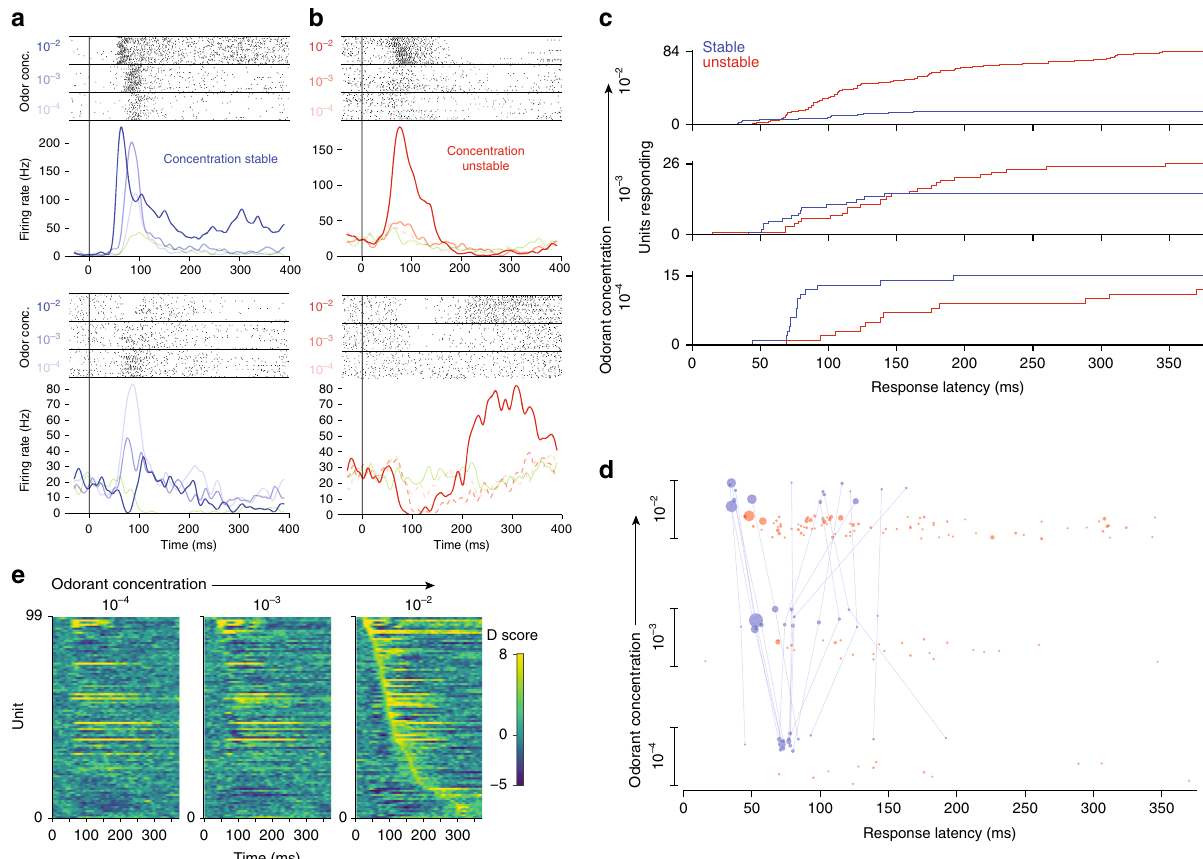
Fig. 4 Concentration invariant MT cell response latencies correspond with behavior. a Example raster and PSTH of two MT cells, which were responsive to odorant across 3 orders of magnitude concentration. t = 0 corresponds to inhalation onset. b Same plots for MT cells which respond to only a subset of concentrations. Dashed PSTH lines represent responses that did not cross the threshold for signi fi cance (see methods). c Cumulative distributions of MT cell response latencies. d Response latencies of MT cell-odor pairs across concentrations for concentration-stable and unstable units. Units ’ responses across concentrations are connected. Area of each point in the plot is proportional to the Cohen ’ s D-score of the response over non-odor response (see “ methods ” section). Point positions are randomly jittered on the concentration axis for visibility. e Odor responses sorted by units ’ response latencies at the highest concentration of odorant. Responses are represented as D-scores, where positive and negative scores are excitation and inhibition relative to